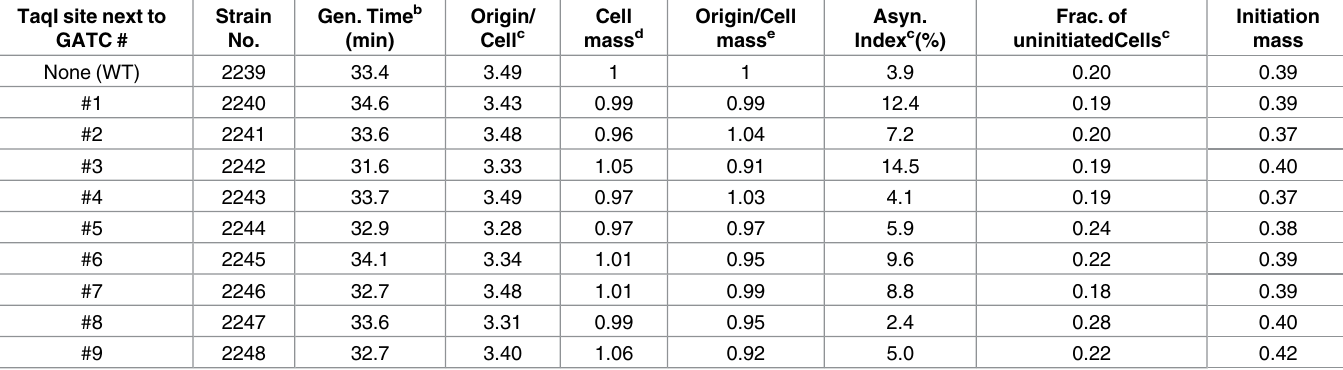
Table 1. Cell cycle parameters of oriC - FRT mutants with TaqI sites a . TaqI site next to Strain GATC #